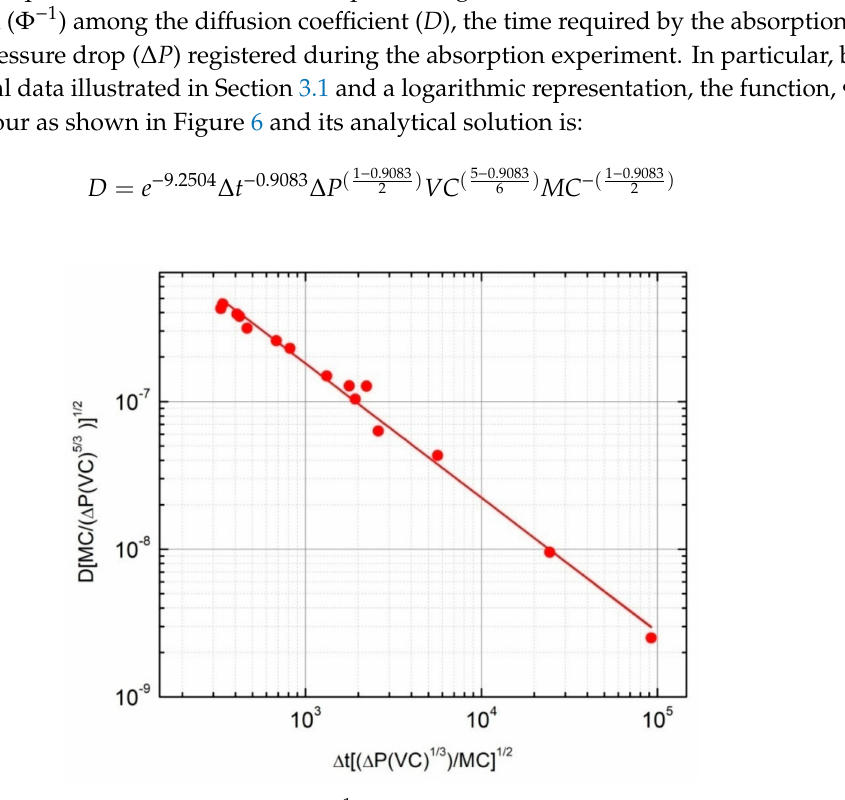
Figure 6. Representation of the function, Φ − 1 using the experimental data with a regression